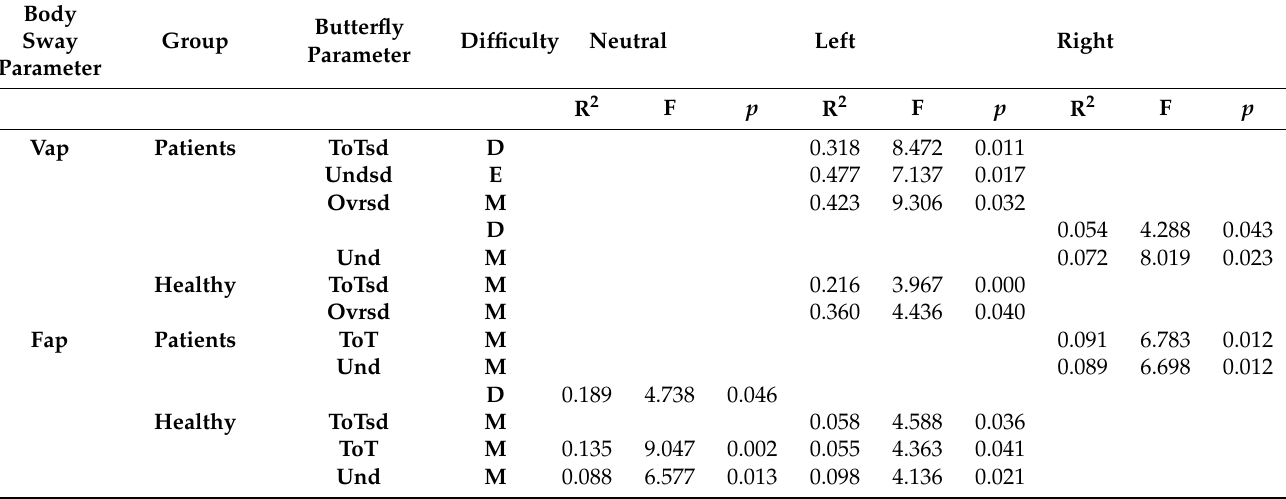
Table 2. Relations between body sway and Butterfly